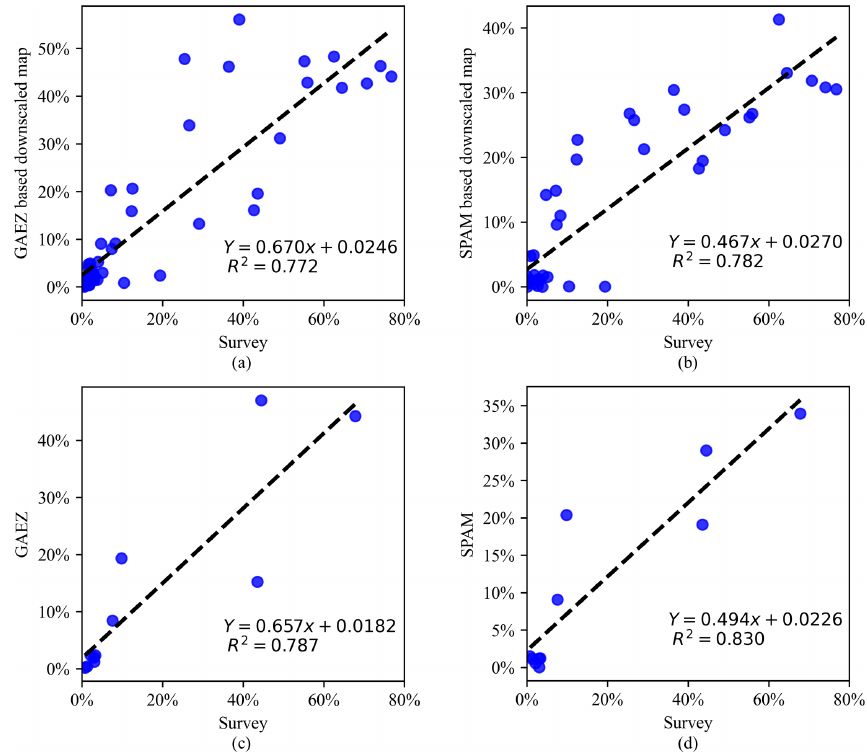
Figure 6. Correlations on the farm-size-specific irrigated area (% of total harvested area per farm size) between household survey data from FAO RuLIS (Rural Livelihoods Information System) database (FAO, 2021) and our GAEZv4-based (a) and SPAM2010-based, farm- size-specific and crop-specific datasets of harvested area (b) , and correlations on the irrigated area of all farms (% of the total harvested area) between household survey data from FAO RuLIS (Rural Livelihoods Information System) database (FAO, 2021) and GAEZv4 (c) and SPAM2010 (d) , all for 11